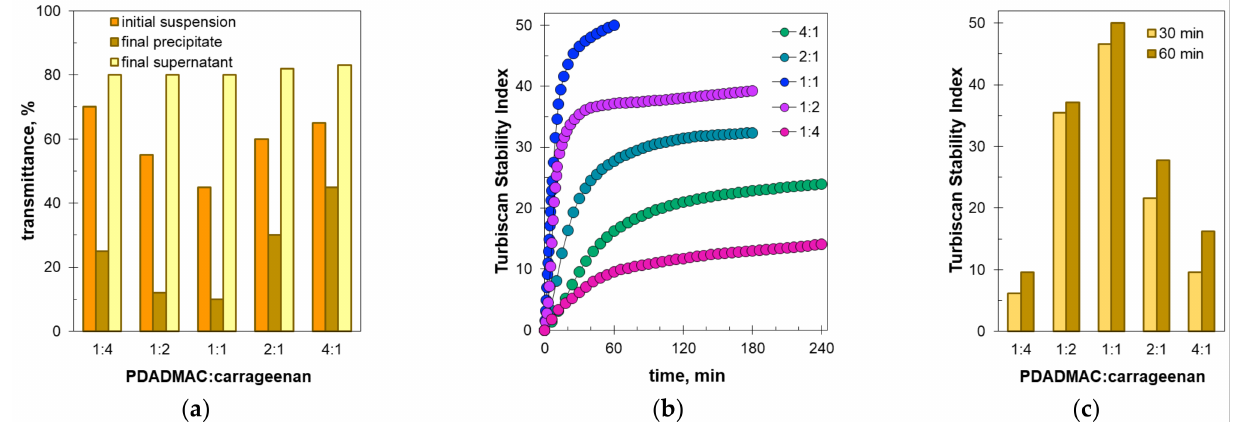
Figure 3. Sedimentation parameters depending on the molar ratio of the polyelectrolytes: ( a ) trans- mittance of initial suspension, final precipitate, and final supernatant; ( b ) changes in TSI values during sedimentation; ( c ) TSI values at the indicated sedimentation